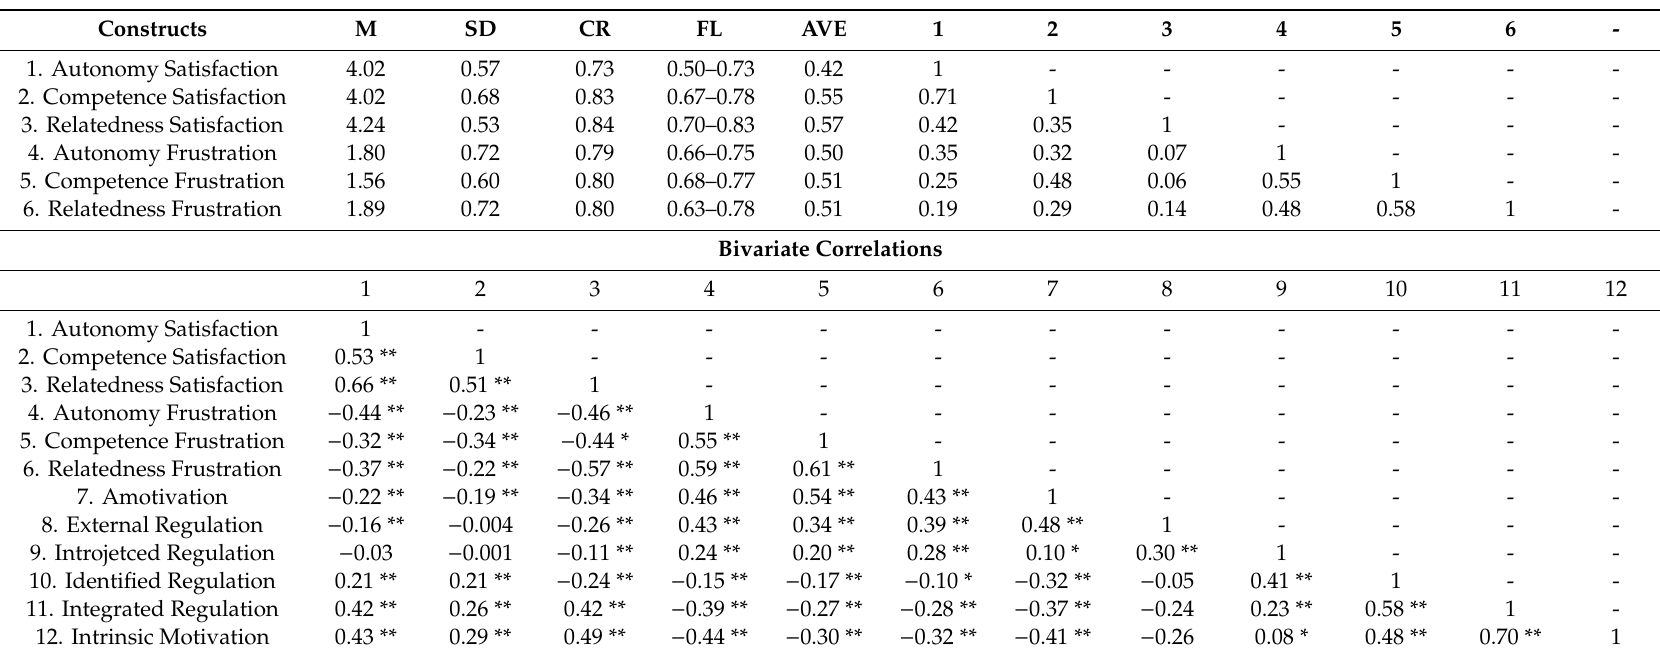
Table 2. Descriptive statistics, internal consistency, convergent and discriminant